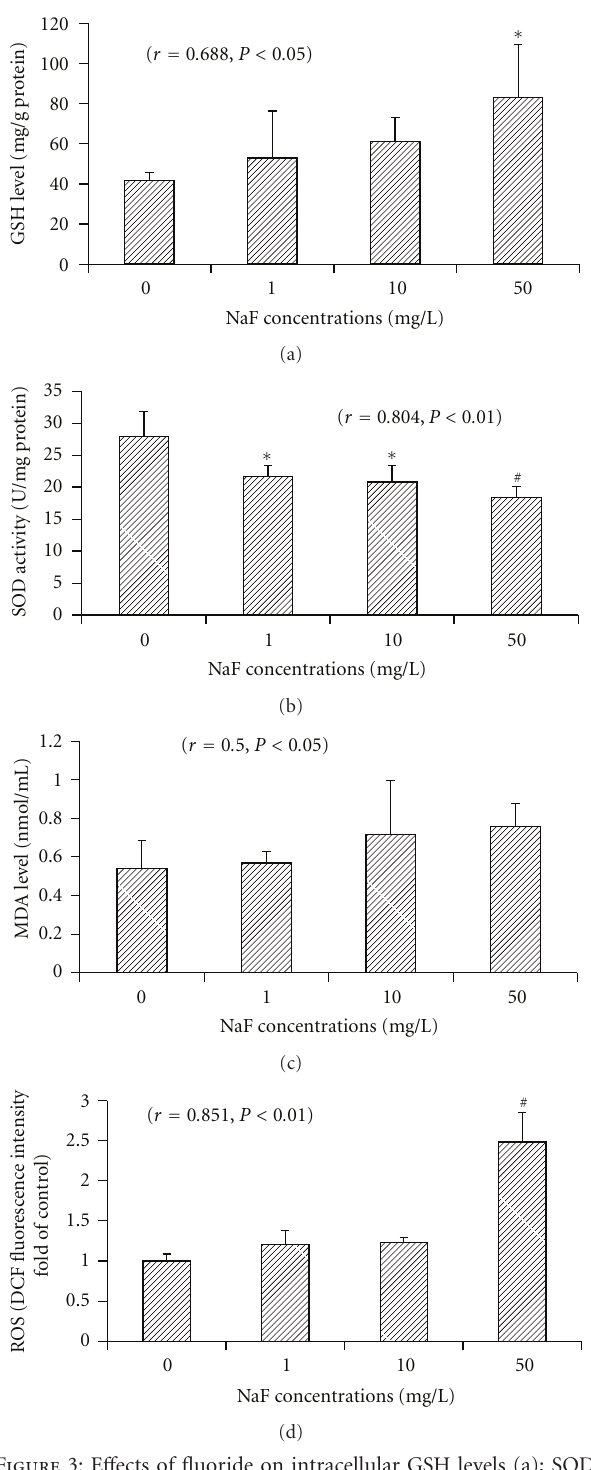
Figure 3: E ff ects of fluoride on intracellular GSH levels (a); SOD activity (b); LPO production (MDA) (c) and ROS production (d) in microglial BV-2 cells. After the cells were treated with various concentrations of NaF (1, 10, and 50 mg/L) for 24 h, the contents of GSH, MDA and the activities of SOD were measured using commercial test kits. DCF fluorescence intensity was measured by flow cytometry for ROS content and DCF fluorescence intensity fold of control was analyzed. Bars were presented as mean ± SD. ∗ P < 0 . 05 and # P < 0 . 01 compared to the control group.